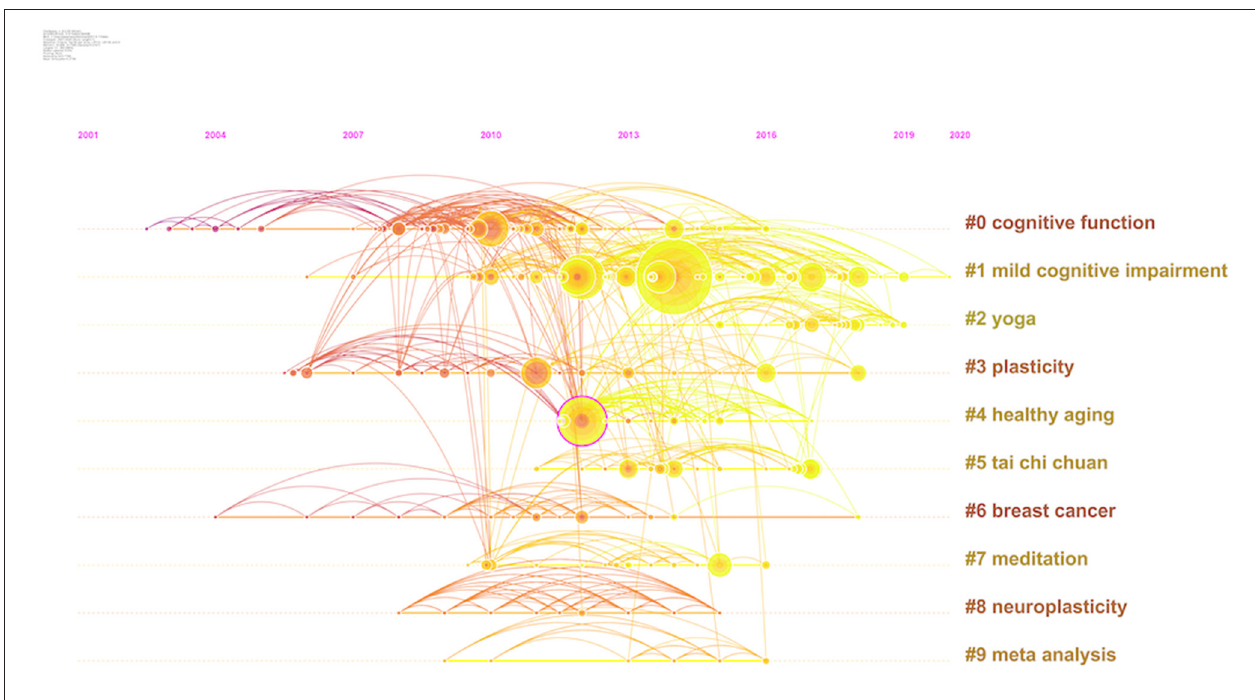
FIGURE 5 | Timeline view of references from 2001 to 2020.